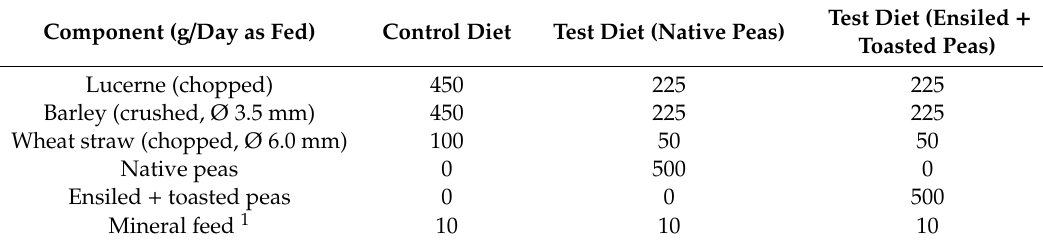
Table 2. Composition of mixed diets o ff ered during the